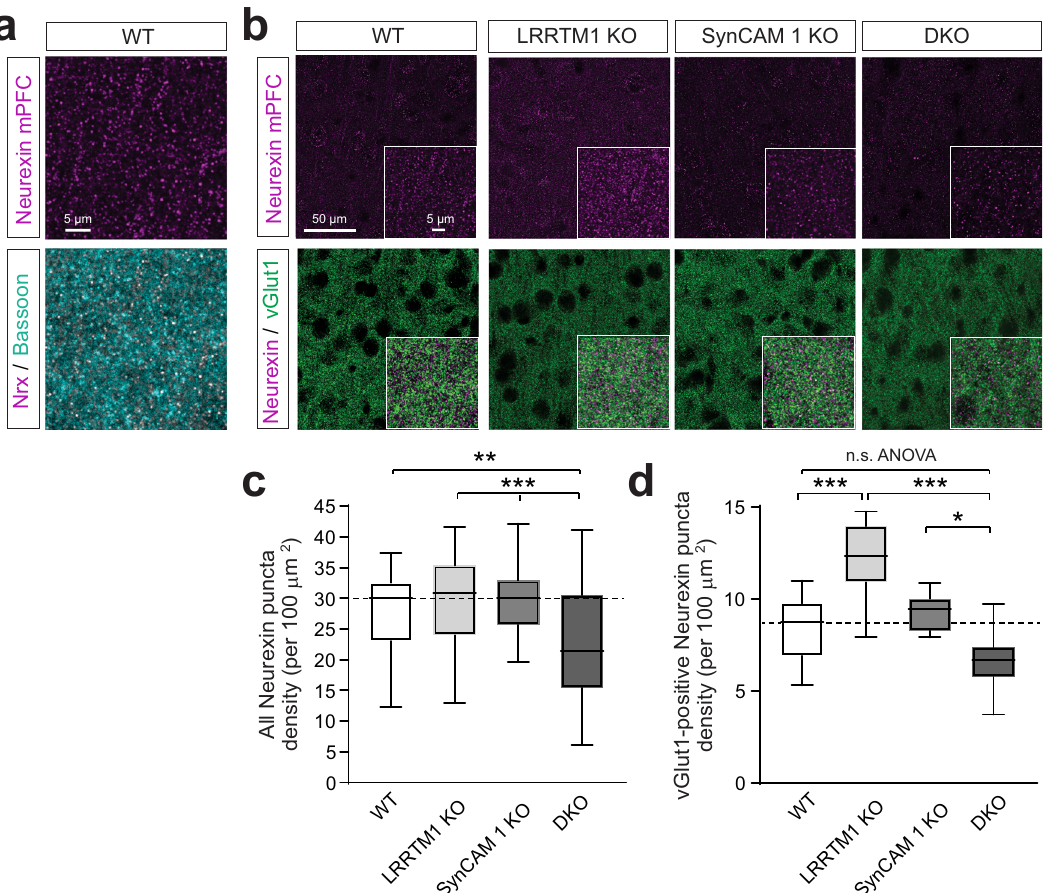
Fig.3|LRRTM1andSynCAM1engageinthetrans-synapticcontrolofNeurexin expression. a Immunostainings of mPFC layer II/III in P55 WT mice for Neurexins (magenta) and the active zone marker Bassoon (green). White marks colocalized sites in the merge. Single 1.0 μ m confocal sections were obtained. The shown example is from prelimbic PFC and representative of results obtained in three independent experiments. Scale bar, 5 μ m. b Top row, Neurexin immunostainings from WT, LRRTM1 KO, SynCAM 1 KO and DKO mice in PFC layer II/III in anterior cingulate, prelimbic, and infralimbic areas at P50. Bottom row, co-staining Neur- exin (magenta) with vGlut1 (green).Single1.0 μ m confocal sections were acquired. Insets show enlarged areas. c Neurexin puncta loss in DKO mPFC. Total